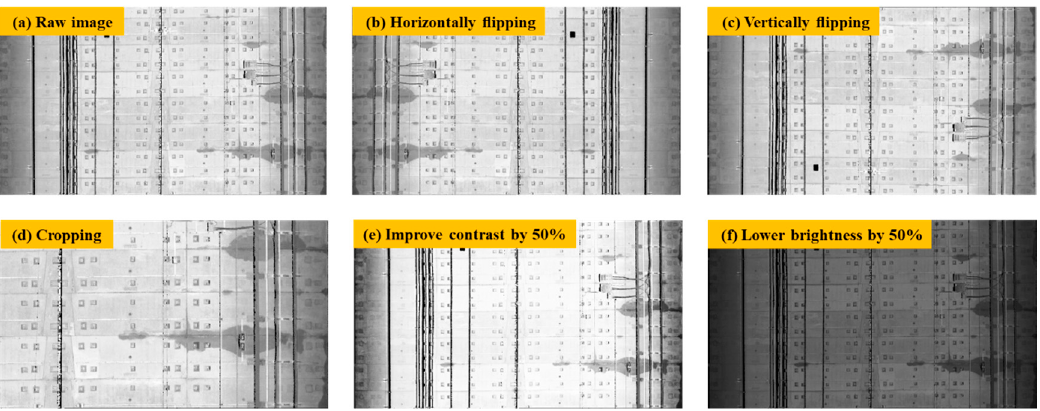
Figure 7. Data augmentation of the 2D grayscale image dataset.